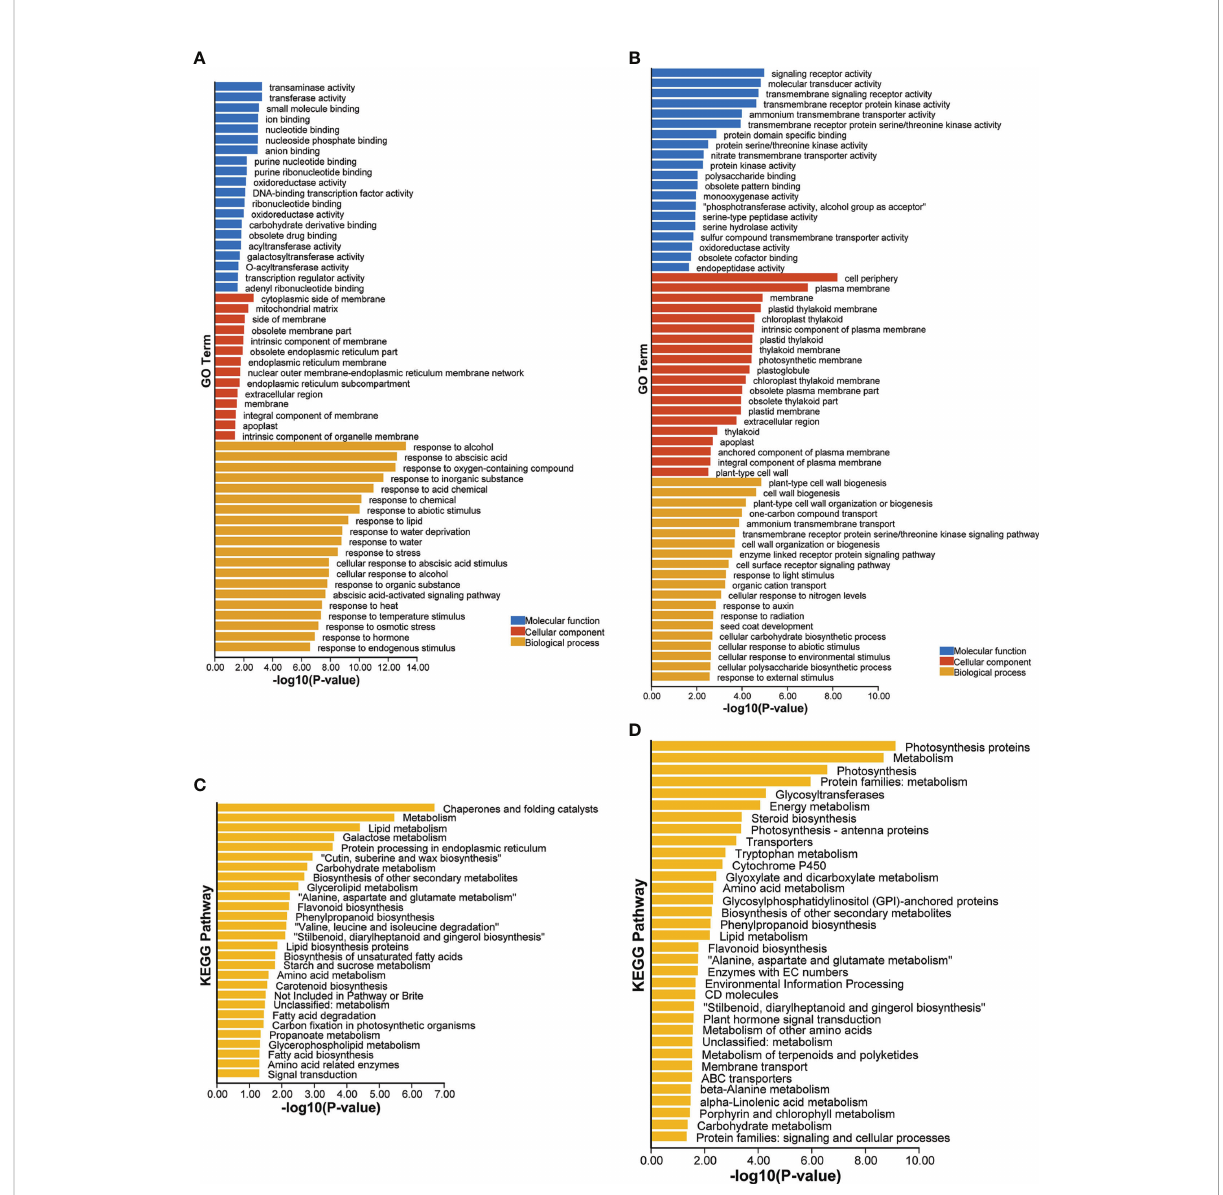
FIGURE 7 Gene ontology (GO) and Kyoto Encyclopedia of Genes and Genomes (KEGG) enrichment analysis of differentially expressed drought-responsive genes between XZSN and LK3. (A) GO enrichment of upregulated drought-responsive genes in LK3 vs. XZSN. (B) GO enrichment of downregulated drought-responsive genes in LK3 vs. XZSN. (C) KEGG enrichment of upregulated drought-responsive genes in LK3 vs. XZSN. (D) KEGG enrichment of downregulated drought-responsive genes in LK3 vs.